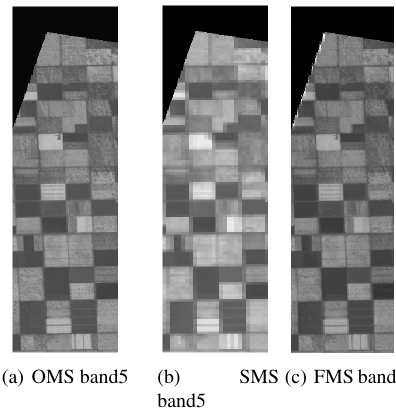
Figure 4: Performance of the Stage 2 spatial detail transfer dotted lines in figure 1(a) due to space constraints. Figure 4(a)